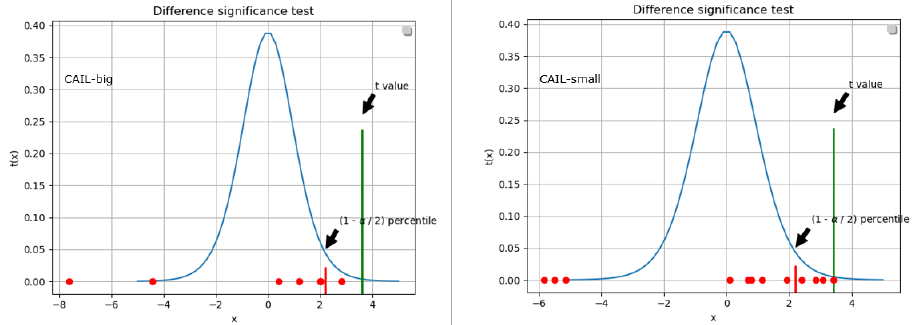
Figure 4. Statistical significance test results between GFDN and